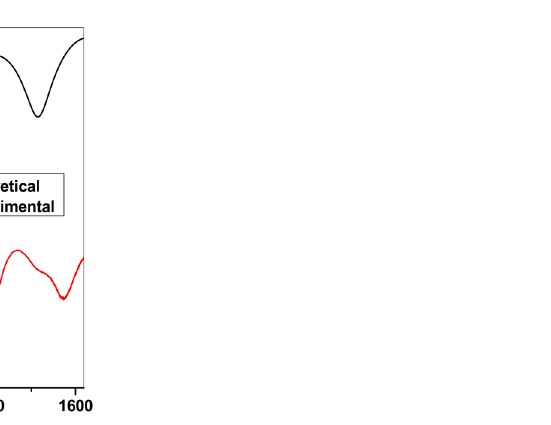
Figure 3. ( a ) Reflection spectra of the device sample. ( b ) Spatial frequency spectra of the device sample.